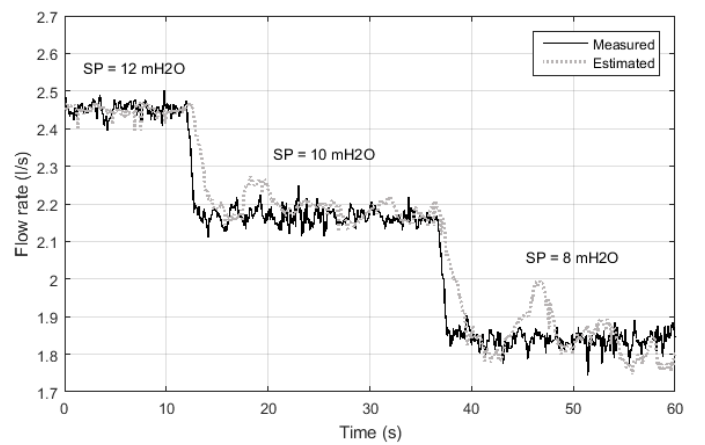
Figure 12. Measurement and estimation of flow during ANN testing using Multi-layer Feedfor- ward